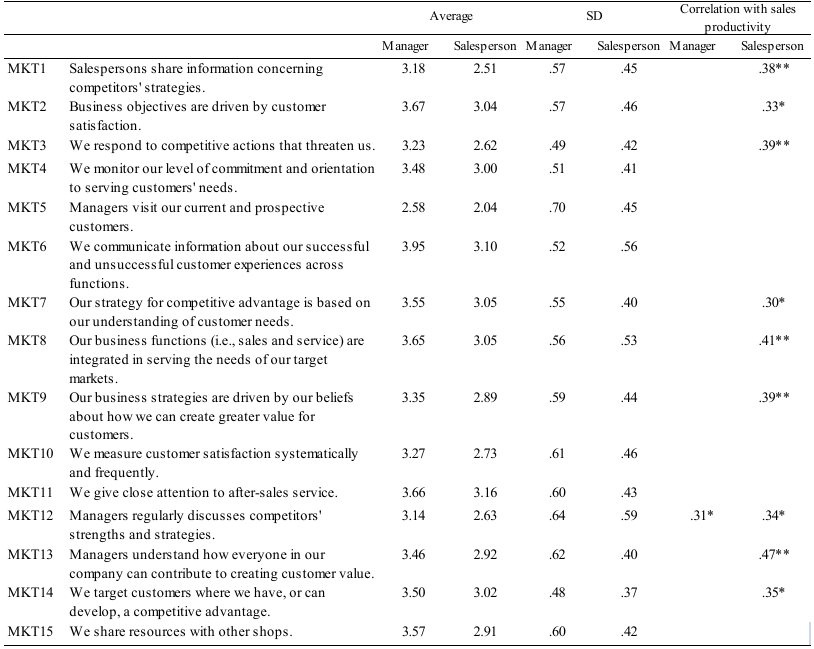
Table 2. MKTOR scale items: Descriptive statistics and pairwise